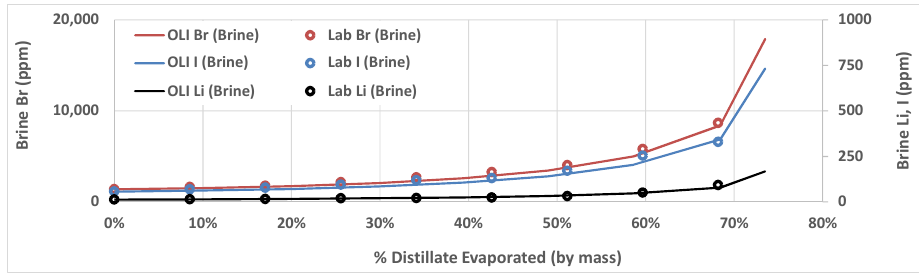
Figure 8. Concentration of bromide, iodide and lithium in brine as a function of PW evaporation. Reference